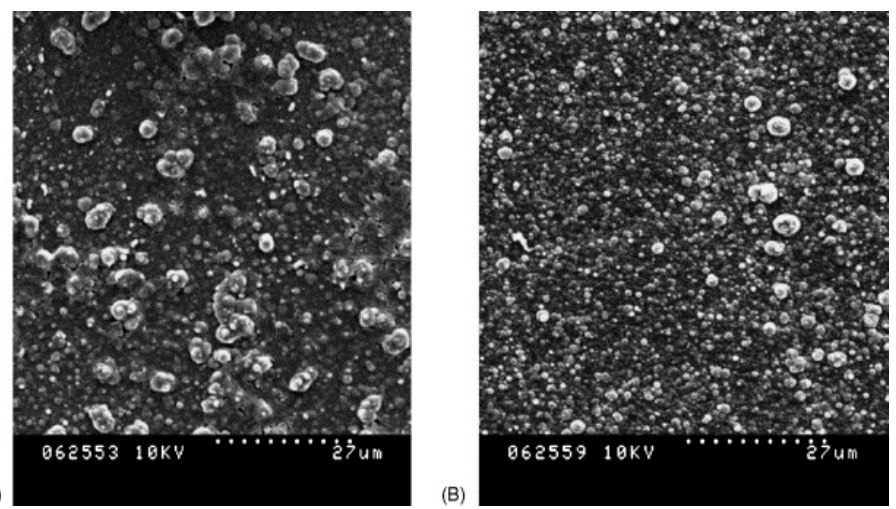
Figure 4. SEM micrographs of a PPy/poly(3 ‐ methyl thiophene: ( A ) non ‐ imprinted film, ( B ) a B. subtilis ‐ imprinted film. Reprinted with permission from [108]. Copyright 2007 Elsevier.